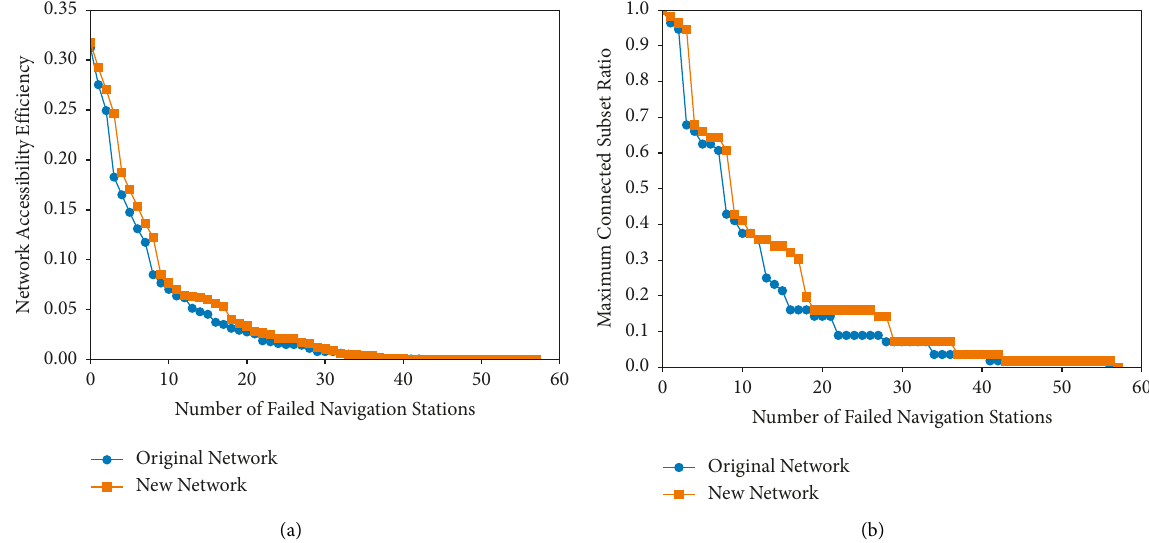
Figure 9: Network topology and function changes under malicious attack based on comprehensive importance of navigation stations: (a) Network accessibility efficiency. (b) Maximum connected